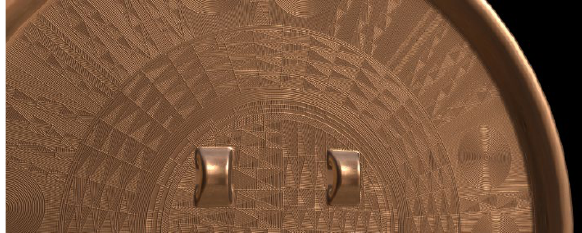
Figure 1. Computer graphics-based 3D modeling of the bronze mirror with fine linear